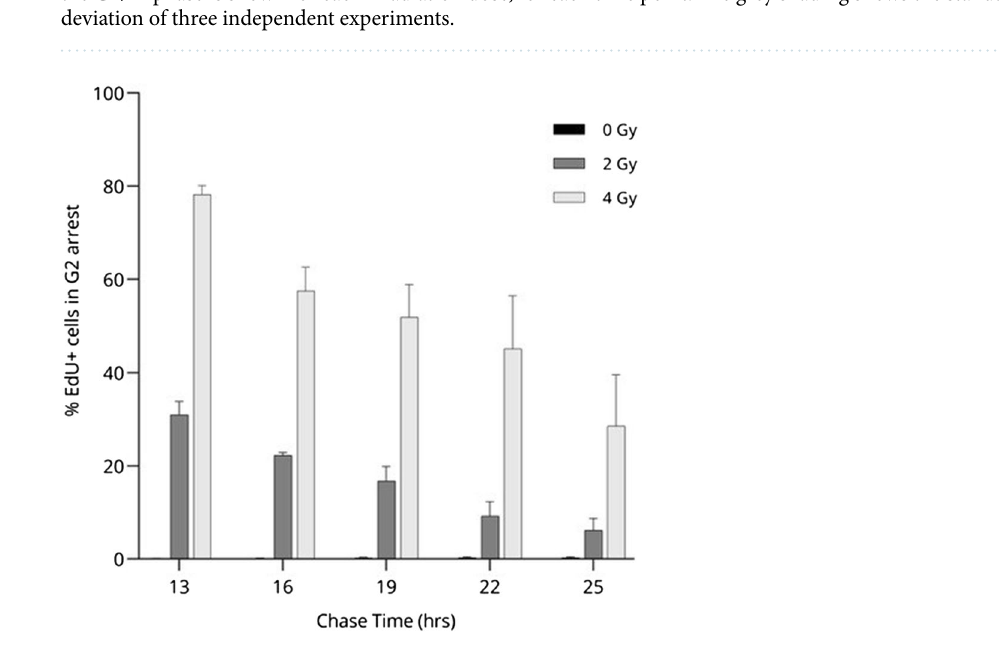
Figure 5. Progression of EdU-labeled T lymphocytes through both the G1 and the G2/M phase over time. ( a ) Datapoints show the mean percentage of EdU-positive cells for each irradiated dose in the G1 phase, for all time points. The grey shading shows the standard deviation of three independent experiments. The blue and red arrow indicate the cell cycle delay for 2 and 4 Gy, respectively. ( b ) The mean percentage of EdU-positive cells in the G2/M phase is shown for each irradiation dose, for each time point. The grey shading shows the standard deviation of three independent experiments.